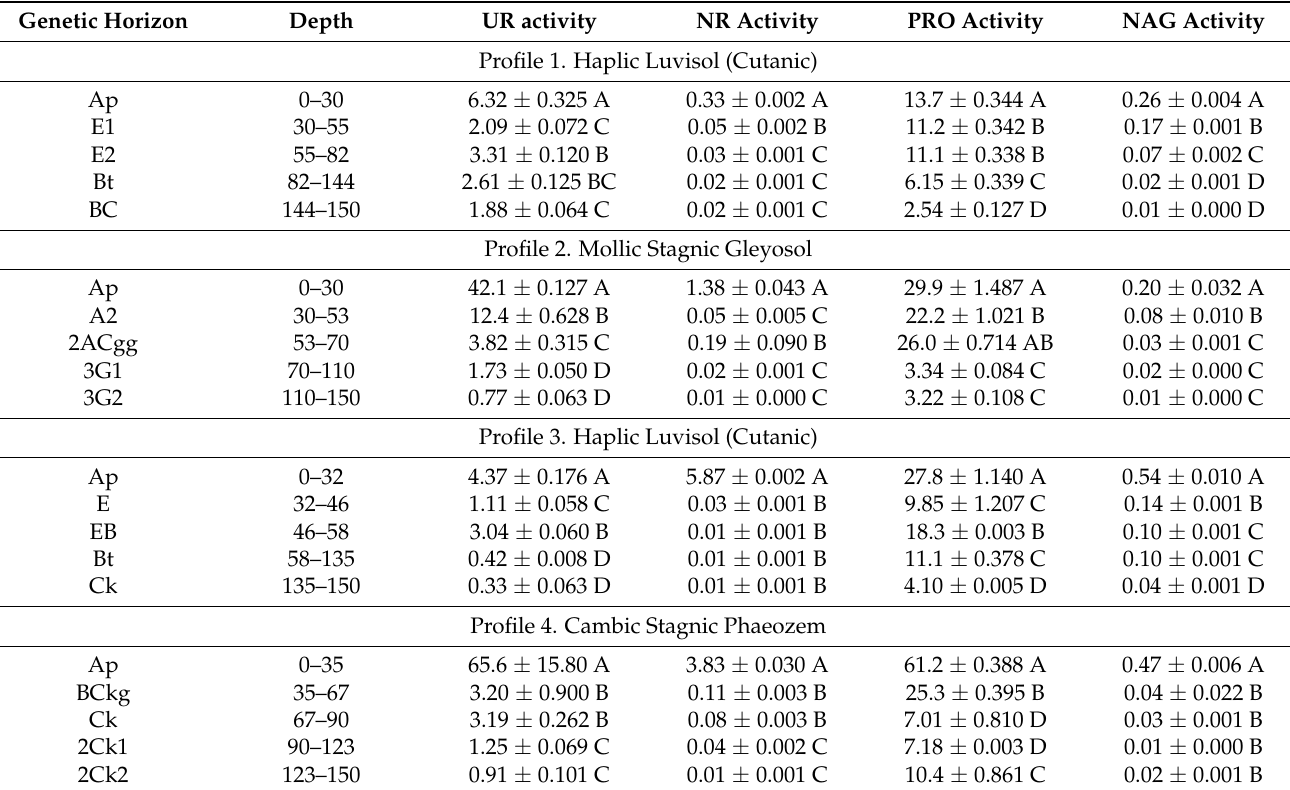
Table 4. Depth distribution of the soil absolute enzyme activities; mean ( ± SE), n =